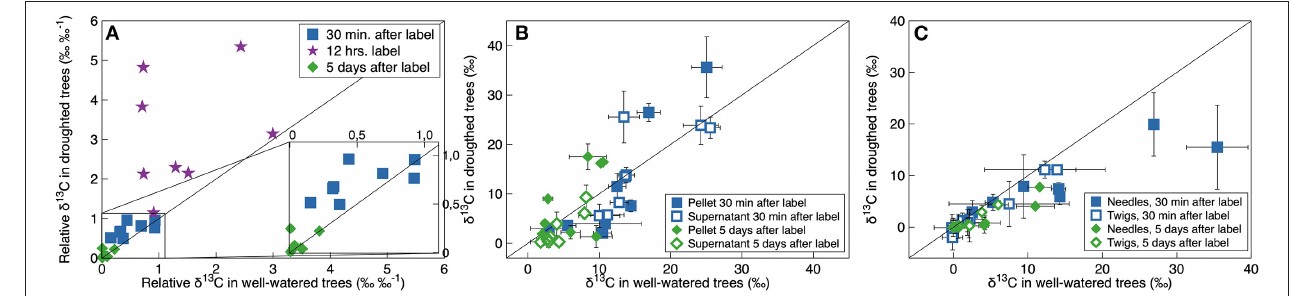
FIGURE 4 | Relationship between δ 13 C in well-watered and droughted P. mariana trees in (A) CO 2 efflux from the respiration, (B) non-structural-carbohydrates and (C) needles and twigs, 30min (blue squares), 12h (purple stars), and 5 days (green diamonds) after 13 C-pulse labeling. In panel a, values are relative to values of respiratory CO 2 δ 13 C immediately after the labeling had stopped. In (B,C) values of δ 13 C are adjusted according to labeling strength. Values are individual branches [in (B,C) error bars indicate the variation (SD) from 3 to 4 shoots on that particular branch] from different 13 C-pulse labeling events, thus in different developmental stages. The black line is the one-to-one relationship.